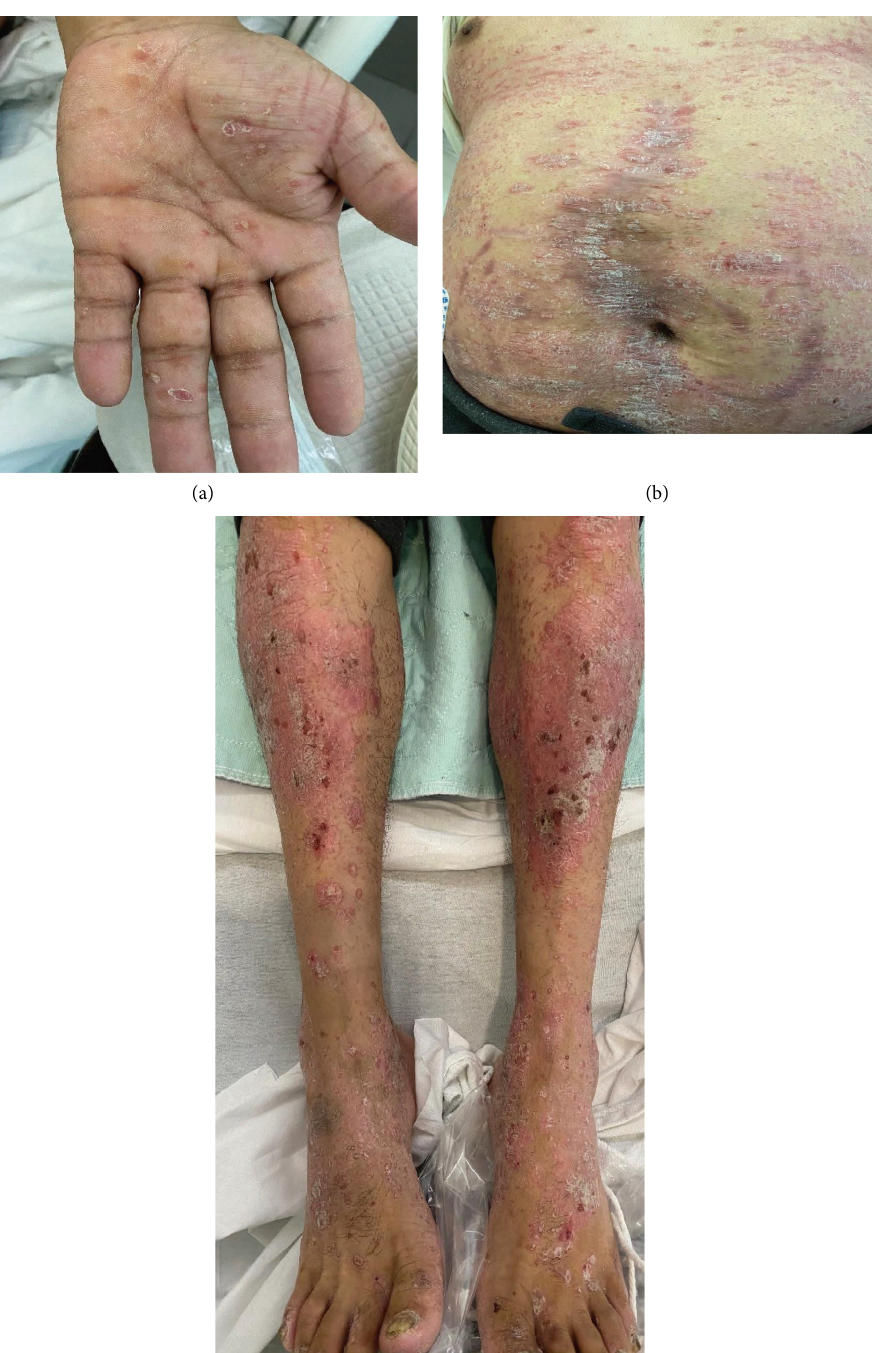
Figure 1: (a–c) Psoriasiform dermatitis. Clinical images depicting difuse sharply demarcated pink plaques with white scale on the left palm, abdomen, and bilateral lower